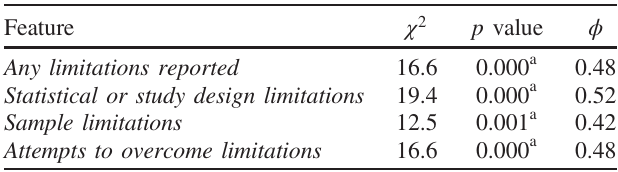
TABLE IV. Fisher ’ s exact tests on limitation